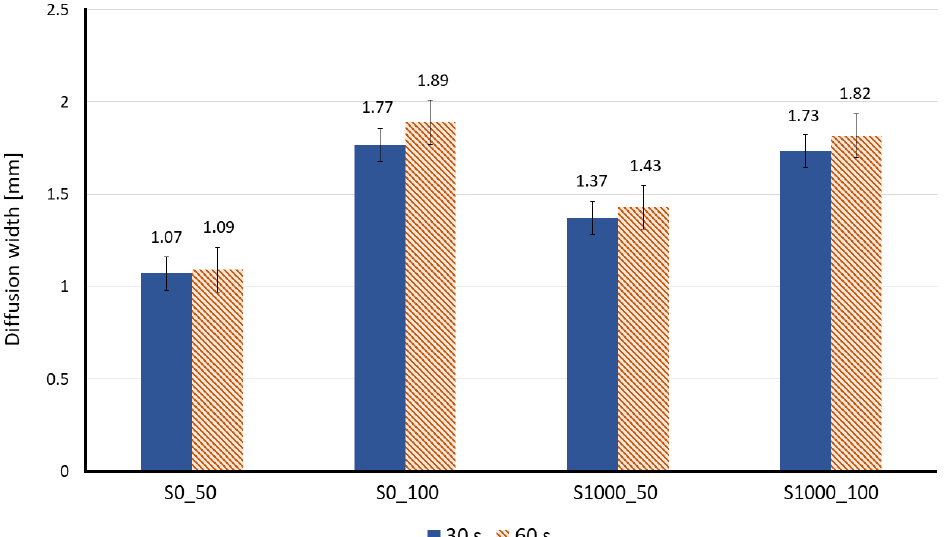
Figure 11. Comparison of measured diffusion width in lab-made Sisal papers at 30 s and 60 s after the “Time zero” for 0.1 M tartaric acid.